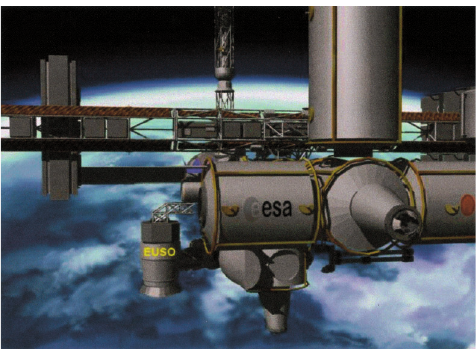
Fig. 7. EUSO at the COF-EPF.